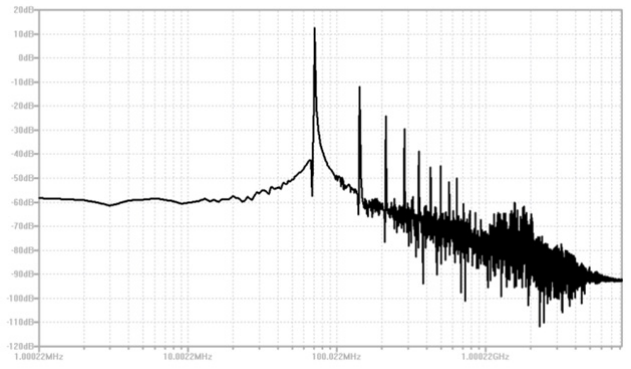
Figure 12. Simulation result of RF oscillator at 450